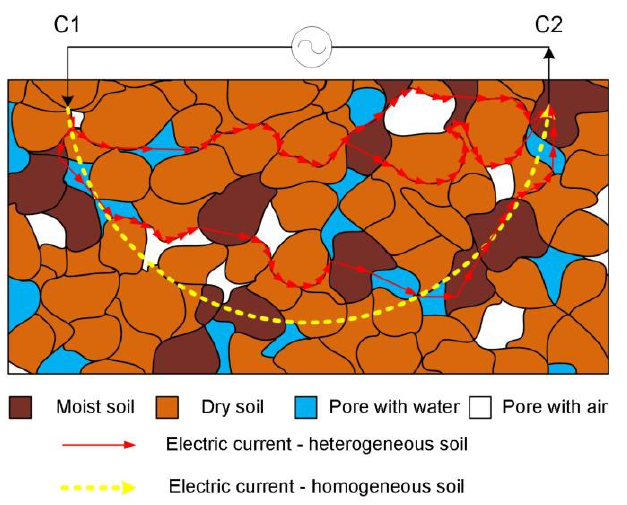
Fig. 1. Path of electric current in the soil.